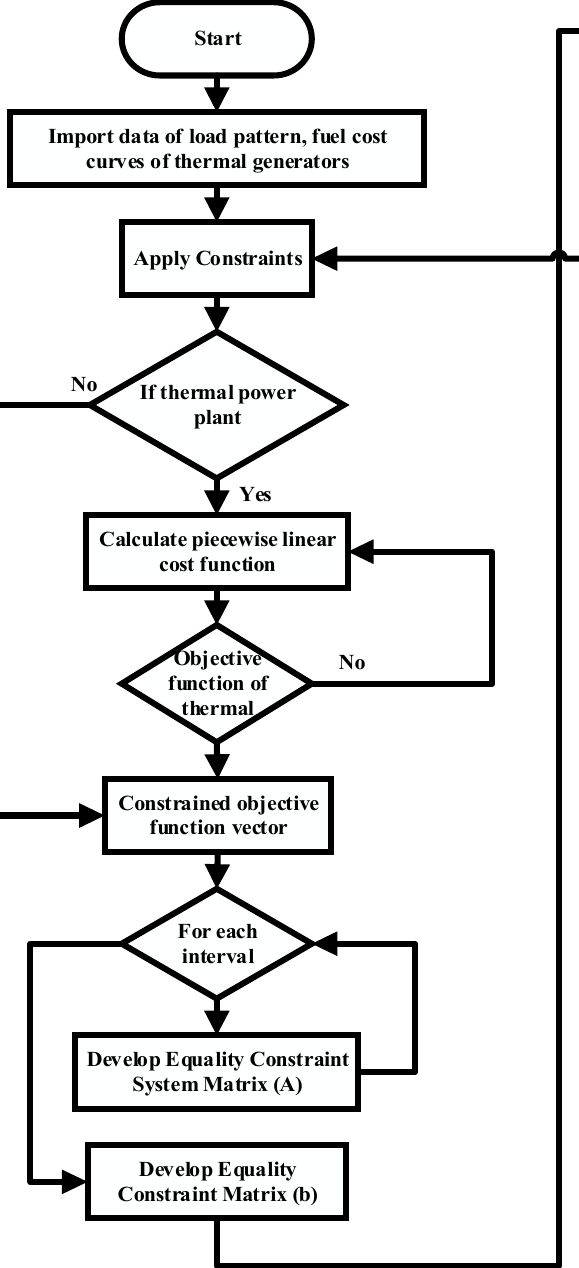
Table 1. Step-by-step implementation of proposed procedure. Step-by-Step Implementation of Proposed Procedure for Coordinated/Optimal Eco- nomic Operation of Hydrothermal Units with HVDC Link Based on Lagrange Multi- pliers